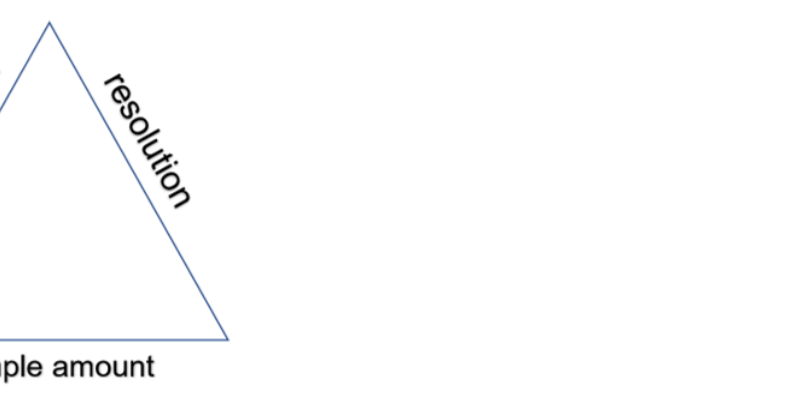
Figure 2. Separation triangle. Modification of any of the parameters is followed by changes of two other.